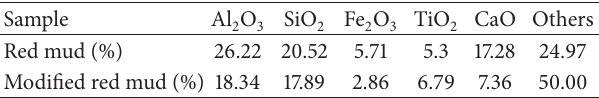
Table 1: The chemical composition of red mud and modified red mud.